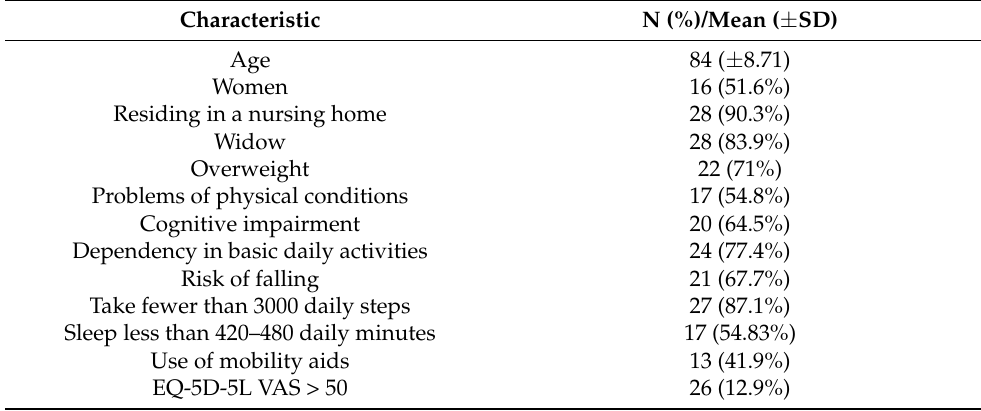
Table 1. Sample main